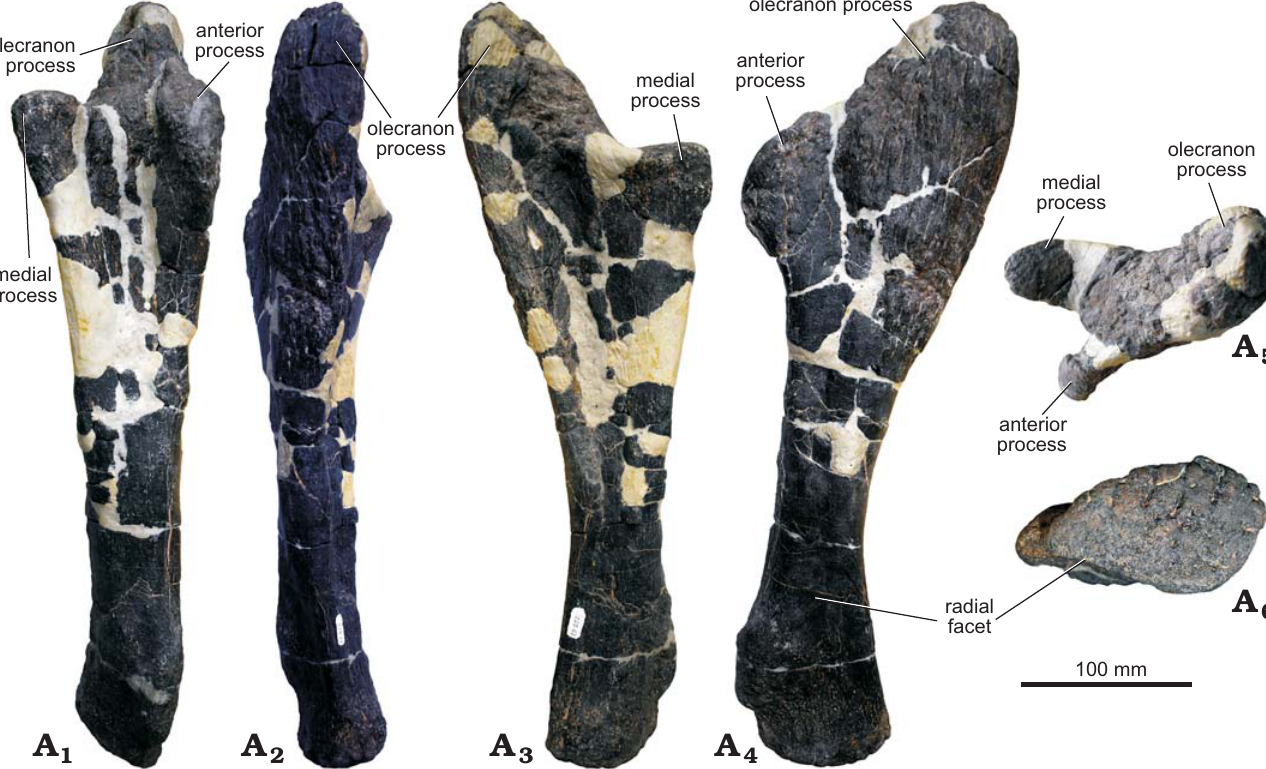
Fig. 4. Left ulna of stegosaur GPDM 205 from the 5E Ranch, Little Snowy Mountains, Fergus County, Montana, USA; in anterior (A 1 ), posterior (A 2 ), lateral (A 3 ), medial (A 4 ), dorsal (A 5 ), and ventral (A 6 )